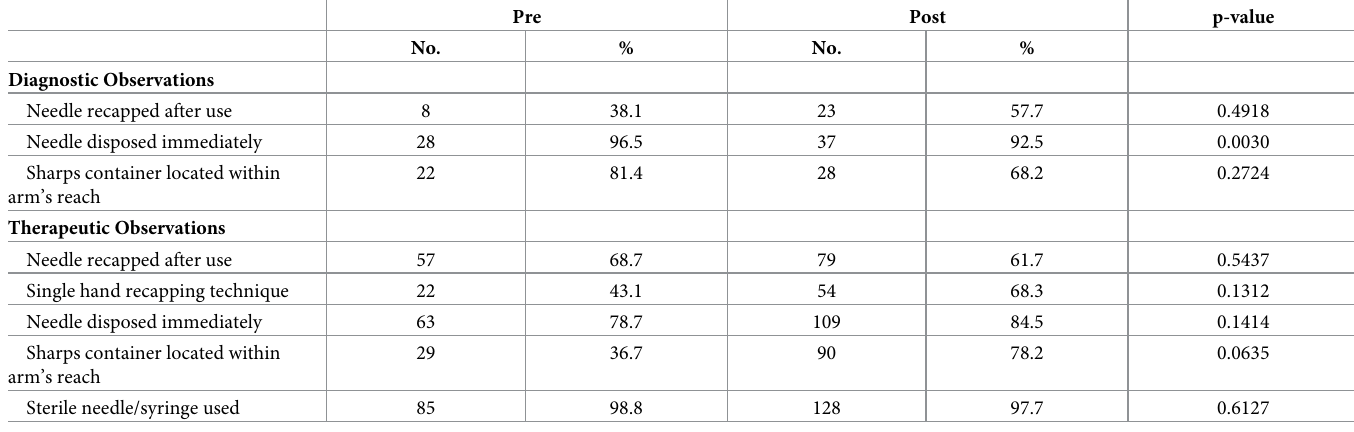
Table 3. Pre- and post-training assessment of safe injection practices affecting healthcare worker safety. Pre Post